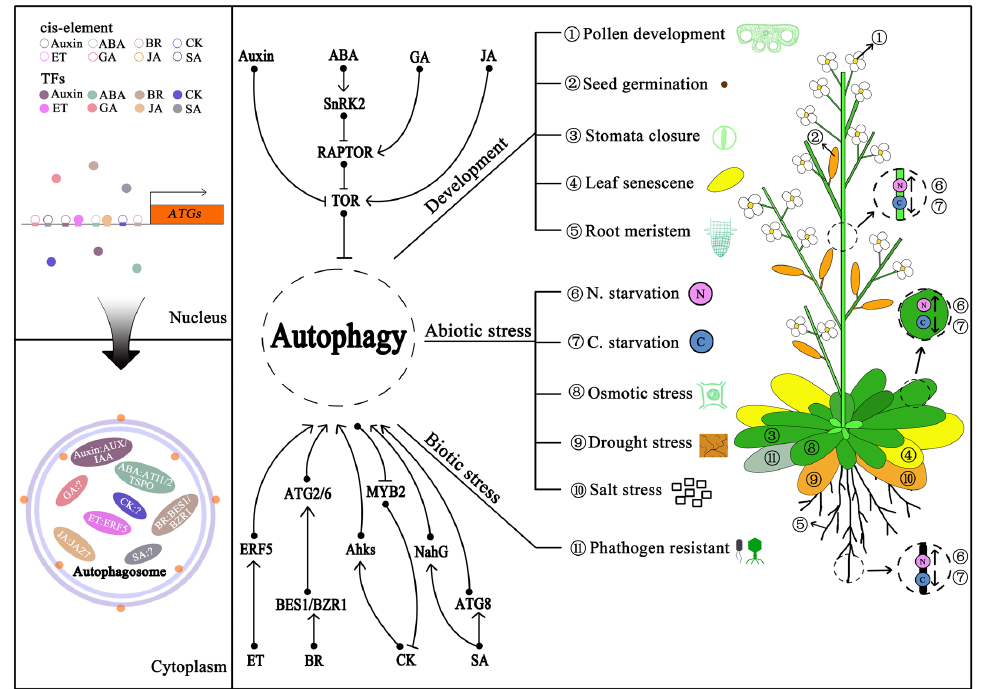
Figure 2. A proposed crosstalk between autophagy and phytohormones. The Figure 2. Aproposedcrosstalkbetweenautophagyandphytohormones. The phytohormones-associated phytohormones-associated transcription factors (TFs) responsible for multiple biological transcription factors (TFs) responsible for multiple biological processes are active or inactive during processes are active or inactive during the plant growth, development and stress response. Upon certain conditions, these TFs are proposed to bind to the ATG8 (and additional ATGs ) promoter to trigger its expression, leading to the induction or inactivation of autophagy as indicated in the left upper square. Subsequently, the cargo receptors (such as phytohormone related proteins) and/or other biomolecules are delivered into the autophagosome, which is then transported into the vacuole for degradation as indicated in the left bottom squares. This process feedback modulates the homeostasis of phytohormones metabolism and signaling transduction at certain stages; eventually, this loop-regulation of each phytohormones with autophagy contributing to different aspects of the plant growth, development and stress response as representatively indicating in the right square from No.1 to No.11. 5. Contribution of Autophagy to Crop Productivity and Yield Autophagy has broadly indicated its role in crop productivity and yield. For example, deletion of OsATG7 caused the abnormal development of anther, sterile of spikelet, early leaf senescence, and low NUE, eventually leading to yield loss [10,13]. Further study revealed that anther defect of osatg7 was partially due to the low endogenous level of bioactive GAs [71], which shed a light on the relationship between phytohormones and autophagy in terms of crop productivity. In addition, impaired maize Atg12 also resulted in arrested seedling growth, accelerated leaf senescence and stunted ear development, as well as perturbed N remobilization, which significantly reduced the seed yield and harvest index [12]. Conversely, overexpressing ATG5 or ATG7 promoted growth, seed set and oil content in Arabidopsis [75]. Similarly, up-regulation of ATG8 also remarkably increased the number of effective tillers in rice, and NUE in the grain of both rice and Arabidopsis, finally enhancing the yield without the penalty of plant development deficiency [15,17]. Collectively, these evidences clearly indicate that autophagy positively contributes to the crop productivity and yield, and the relevant ATG genes are great candidates for crop breeding and improvement.